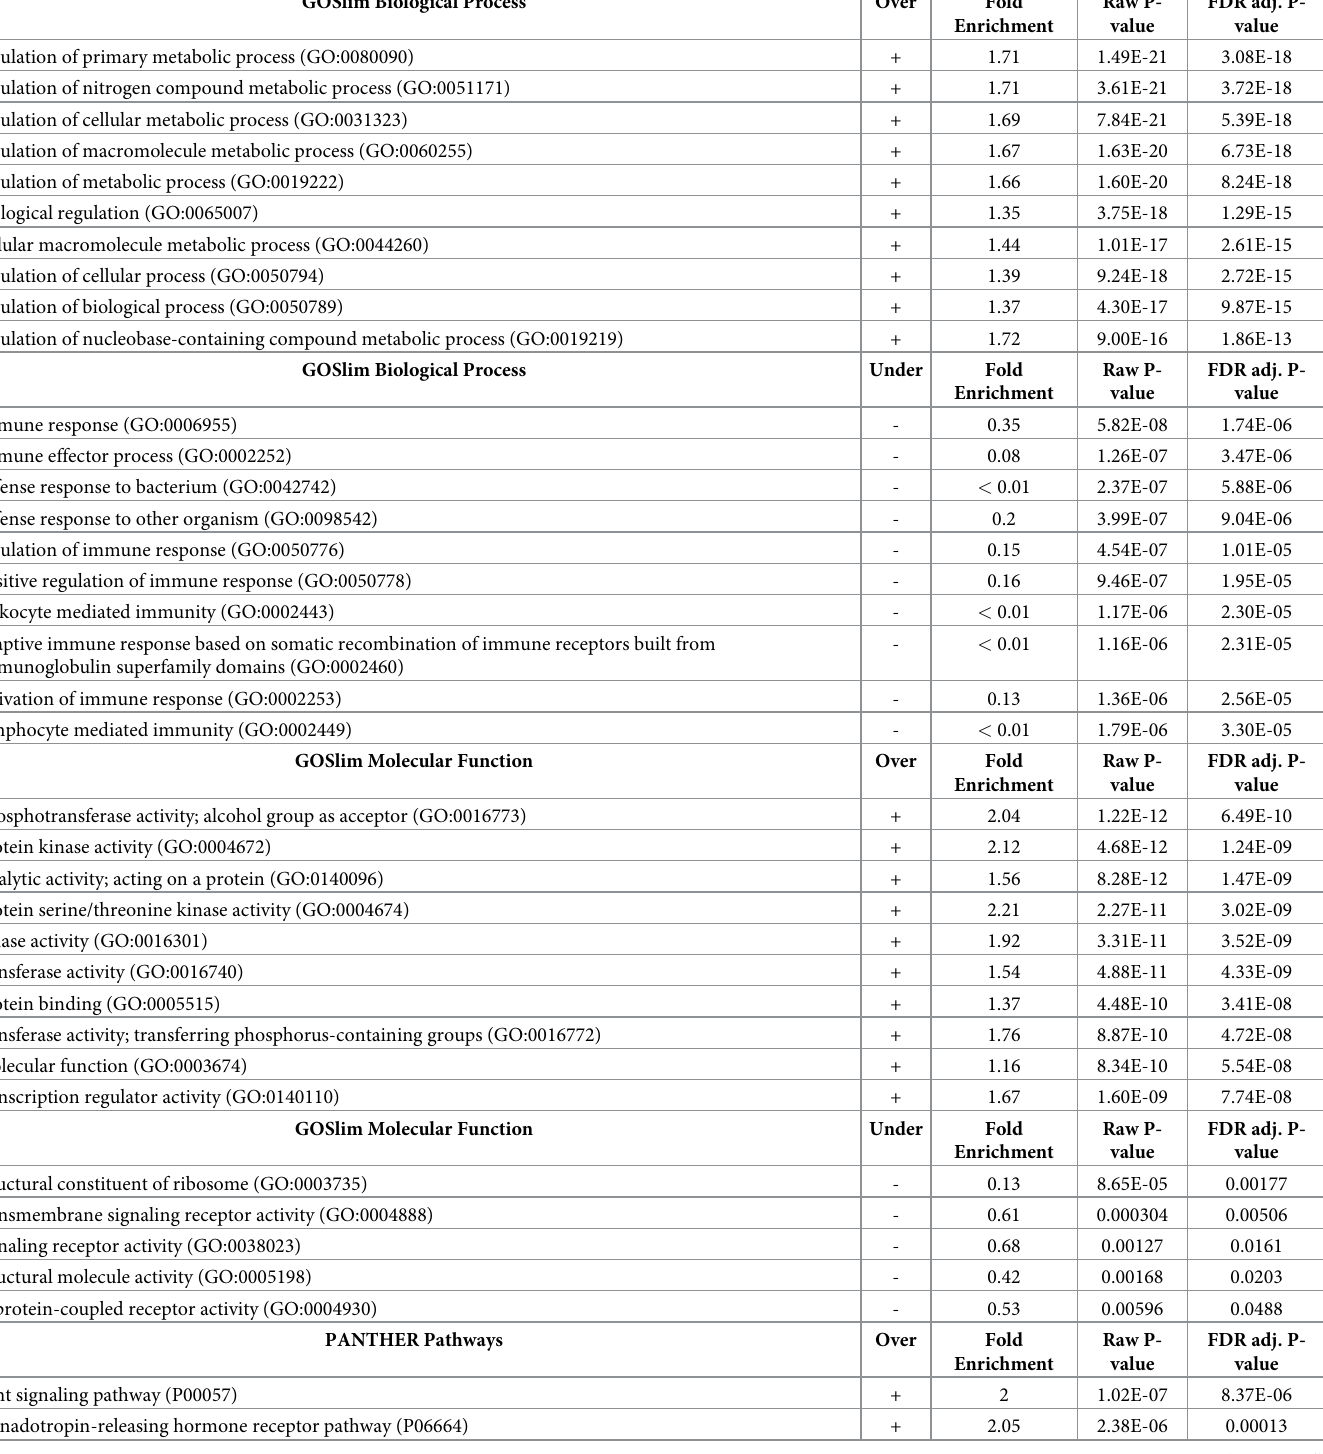
Table 2. Gene Ontology for predicted targets of miRNA significantly associated with GA. The first ten results for gene ontology (GOSlims Biological Process, GOSlims Molecular Function, PANTHER pathway classification) tests for significantly over- and under-represented groups (PANTHER overrepresentation test, FDR P < 0.05)